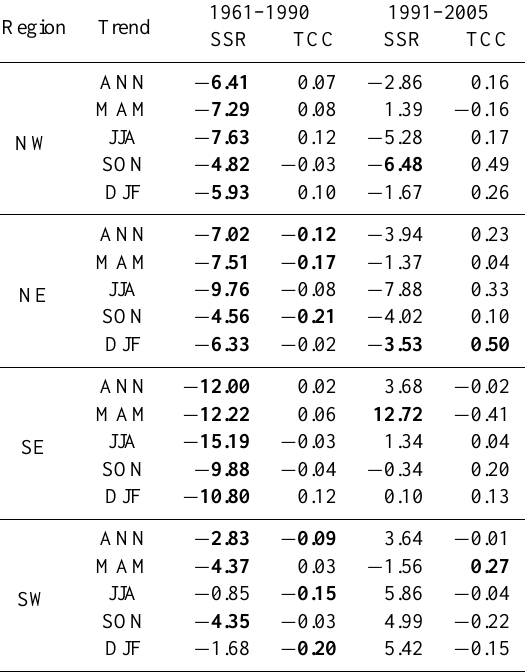
Table 1. The annual and seasonal trends in surface solar radiation (SSR) and total cloud cover (TCC) during 1961–1990 and during